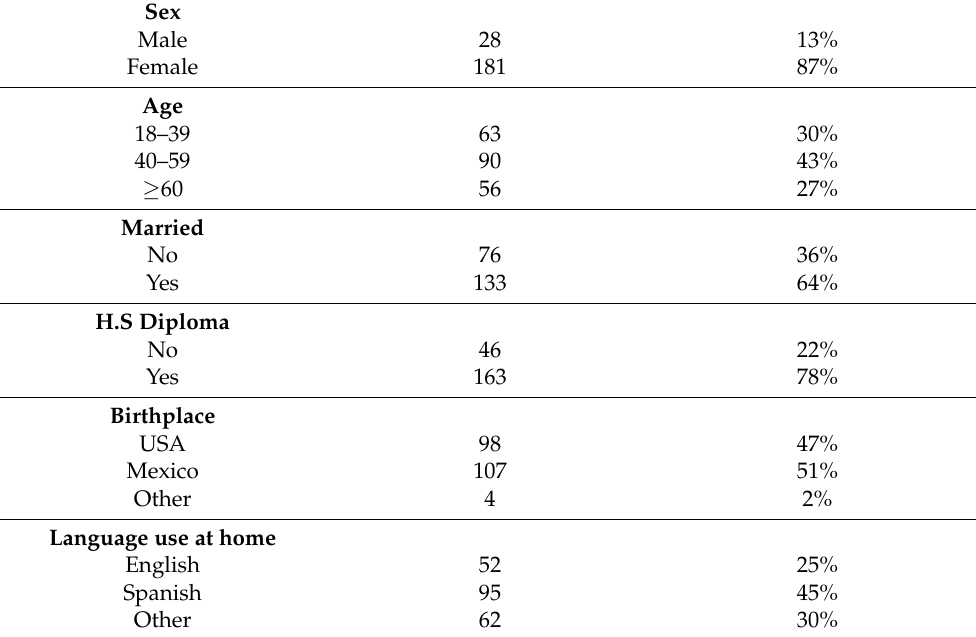
Table 1. Demographic characteristics of the PPPC evaluation study